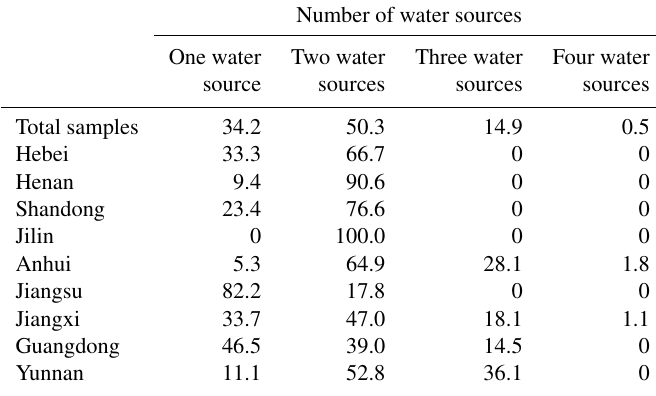
Table 1. Percentage of villages using various irrigation sources in the sample regions (%).